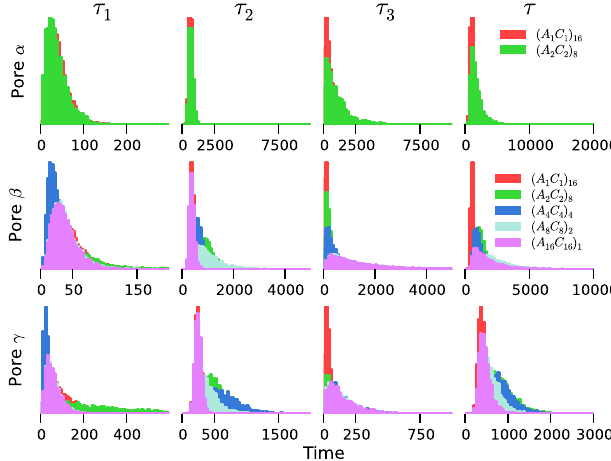
FIG. 10. Comparison of the filling, transfer, escape, and trans- location time distributions for the three pores at F ¼ 1 : 0 and W ¼ 2 : 25 using heteropolymers with different sequences.